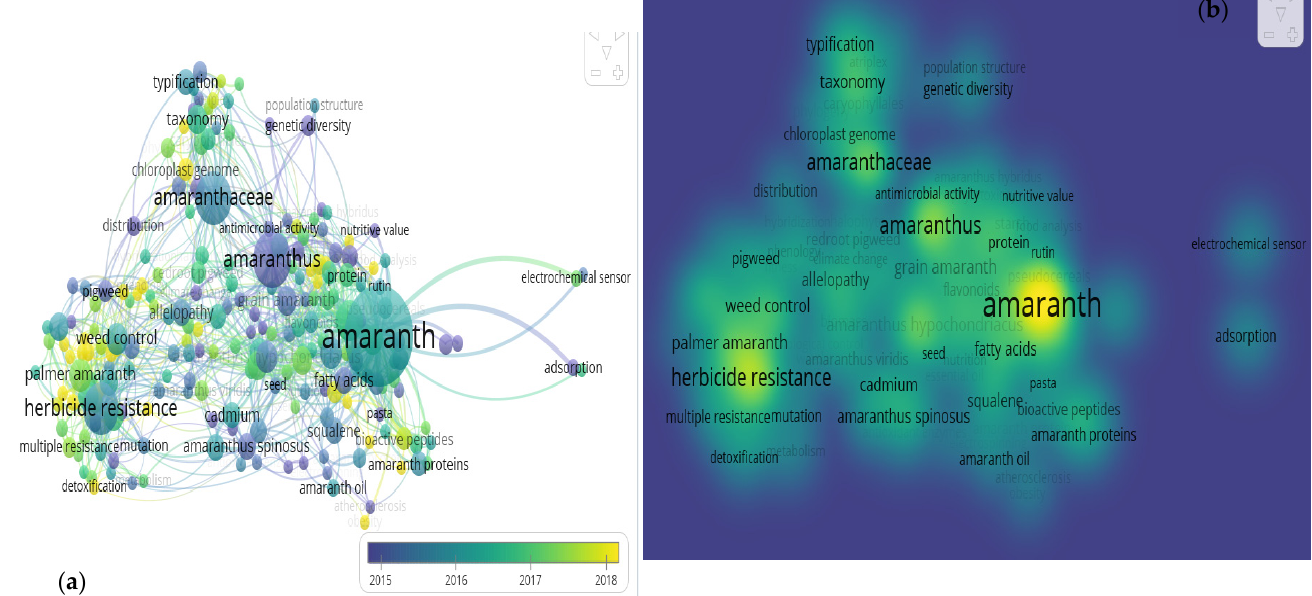
Figure 7. Keywords analysis on research publications on Amaranthus from 2011 to 2020. Overlay visualization ( a ), density visualization ( b ).